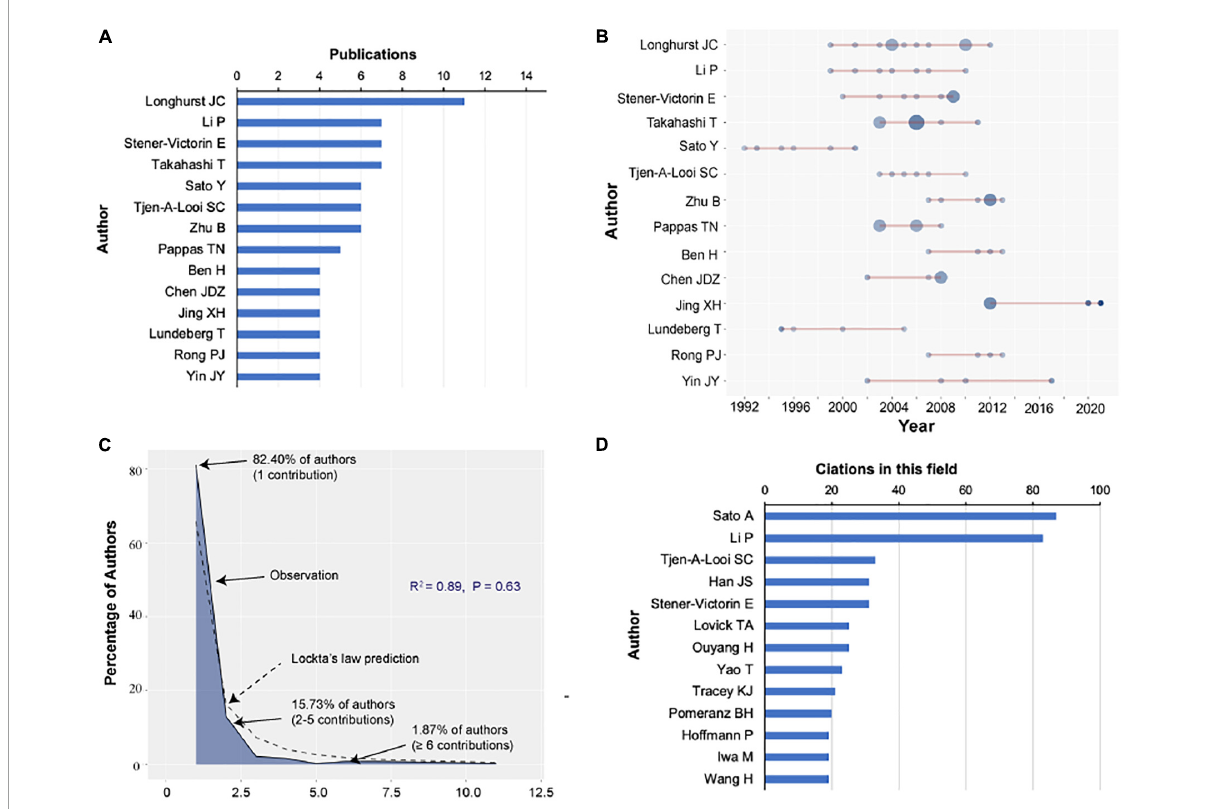
FIGURE4 Analysis of authors. (A) Number of publications from different authors. (B) Total citations in the research filed from different authors. (C) Authors’ production over time. (D) Lotka’s Law on the contribution of authors who published articles in the